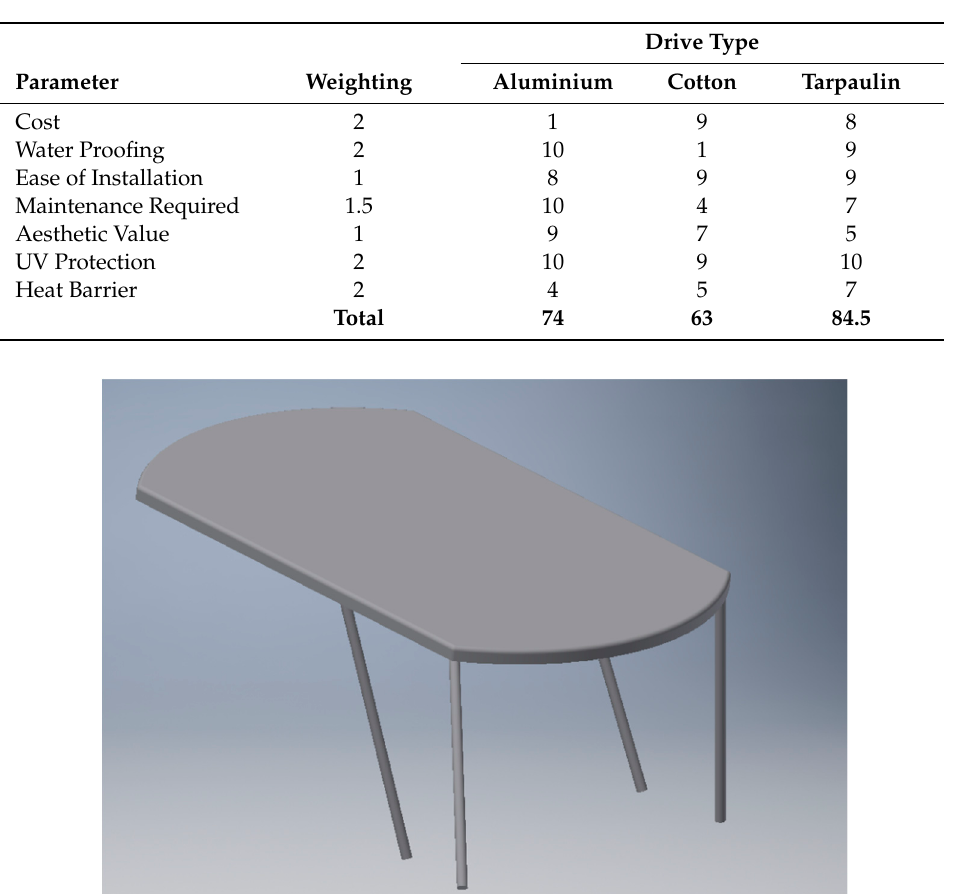
Figure 8. Example of roof panel fabrication.